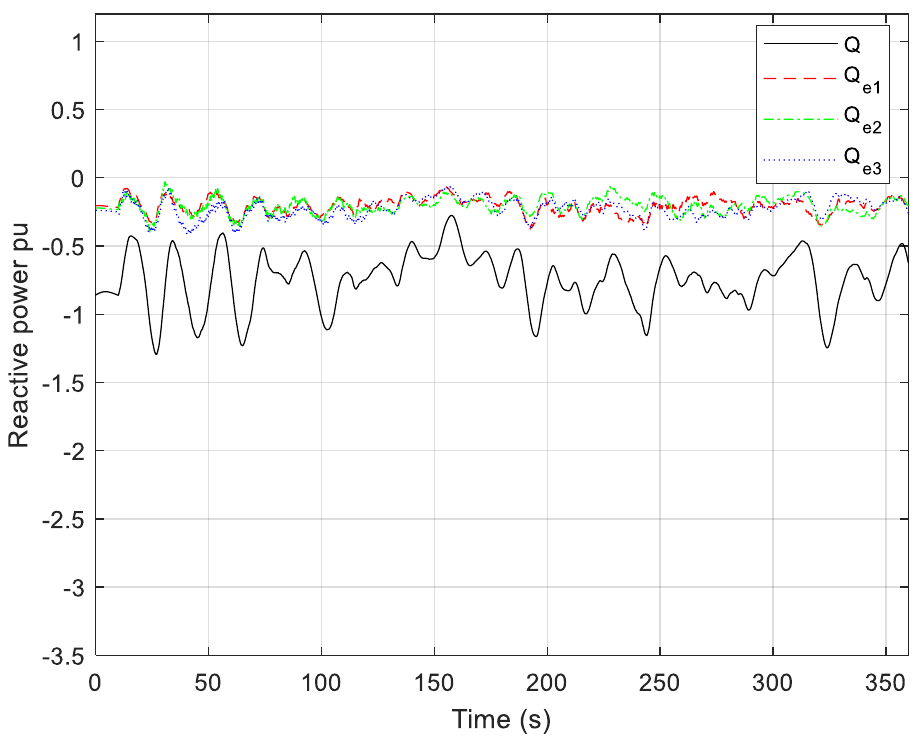
Figure 28. Reactive power of the B2B converter and the reactive powers of PMSGs (random wind disturbance).